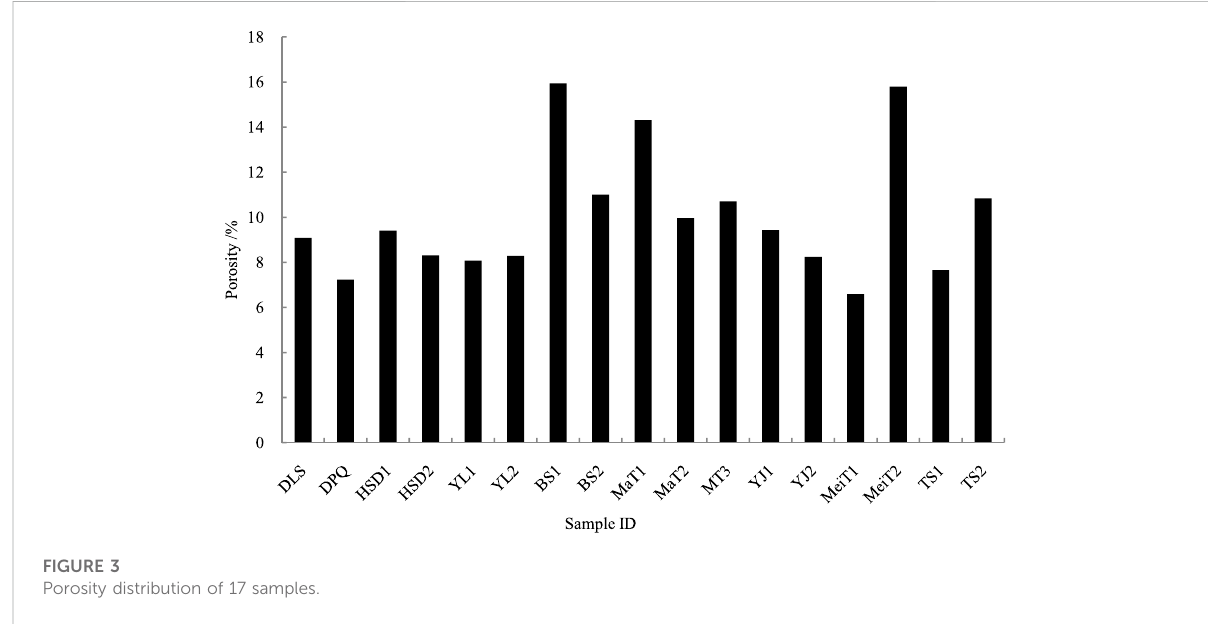
FIGURE 3 Porosity distribution of 17 samples.